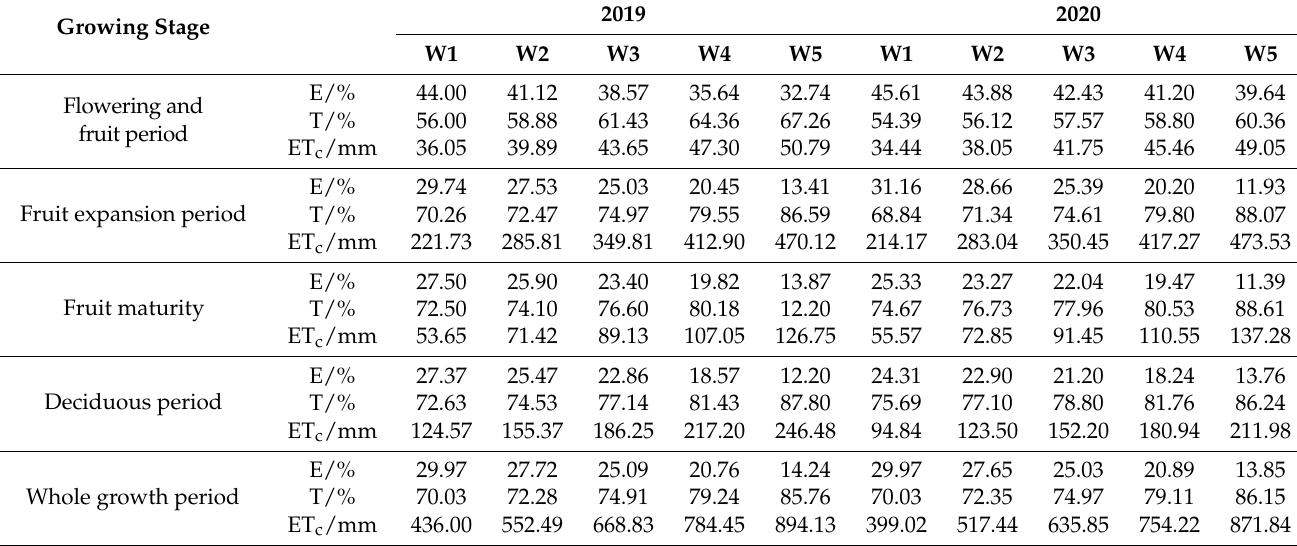
Table 7. Soil evaporation and crop transpiration in different growing periods in 2019 and 2020.